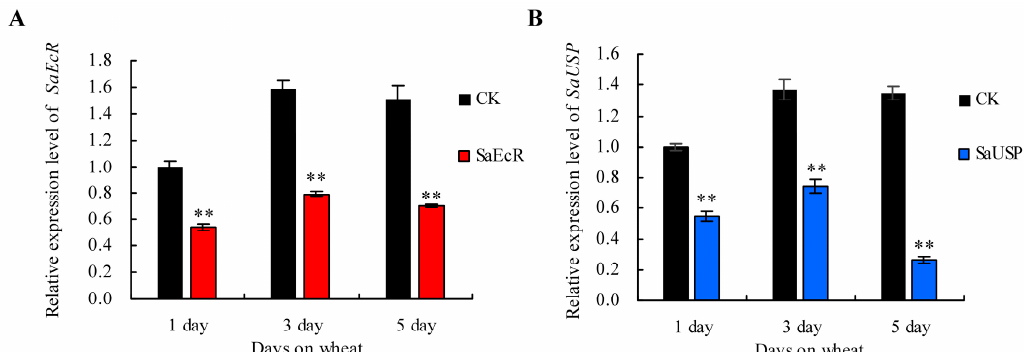
Figure 5. Transgenerational effect of RNAi in the offspring of grain aphids exposed to dsRNAs treatment. The relative expression levels of SaEcR ( A ); and SaUSP ( B ) in neonate nymphs of the aphids exposed to dsRNAs treatment were significantly lower than those fed on CK control (Student’s t -test, n = 3, ** p < 0.01). Bars represent mean values ± SEM of three independent biological replicates, each with a pool of eight individual aphids.